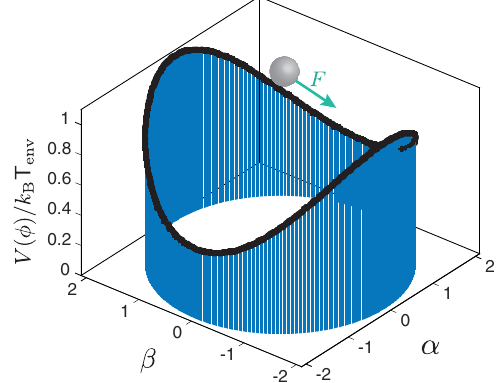
FIG. 4. Illustration of a Smoluchowski-Feynman ratchet. A Brownian particle (gray sphere) immersed in a thermal bath of temperature T moves in a periodic potential V ð ϕ Þ (black env shaded curve) with friction coefficient γ . The coordinate ϕ is the azimuthal angle of the particle. When applying an external force F ¼ γ v in the azimuthal direction, the particle reaches a nonequilibrium steady state. In this example, V ð ϕ Þ ¼ k T ln ½ cos ð ϕ Þ þ 2 (cid:2) , α ¼ R cos ð ϕ Þ and β ¼ R sin ð ϕ Þ , with B env R ¼ 2